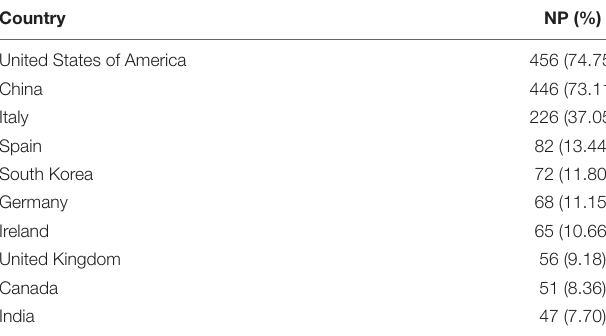
FIGURE 3 | Estimation of publications by year on gut microbiome and AD.